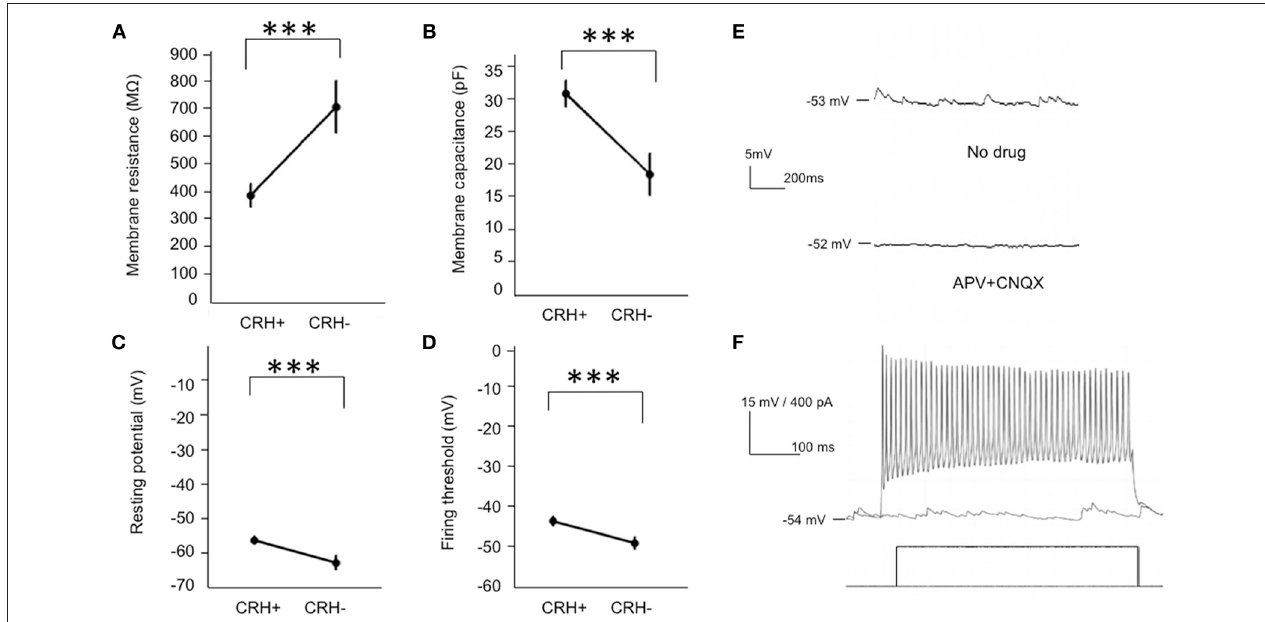
SEM. (E) Upper, a typical trace showing spontaneous postsynaptic currents in a CRH + EPL interneuron. Lower, the spontaneous postsynaptic potentials is largely blocked by APV + CNQX. (F) A representative trace showing a CRH + EPL interneuron firing in response to current